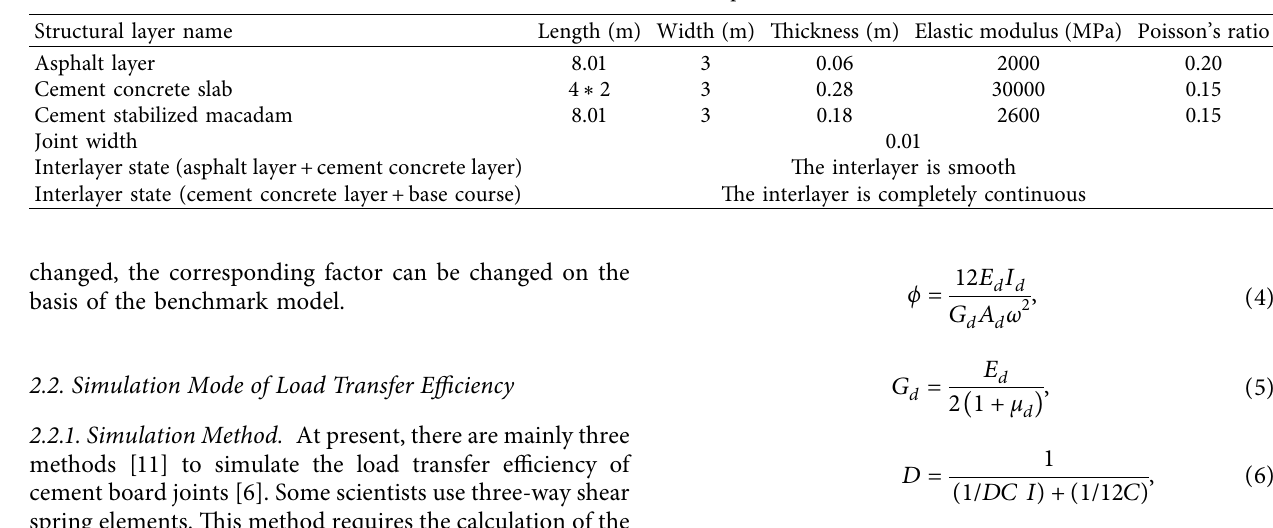
Figure 4: Three-dimensional finite element model with void. Table 1: Benchmark model